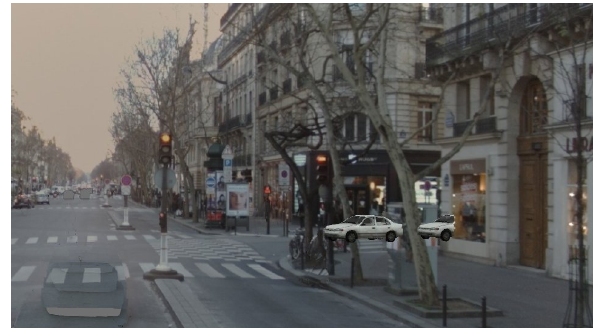
Figure 6: Approximate occlusion of a synthetic car with the LOD1 city model.